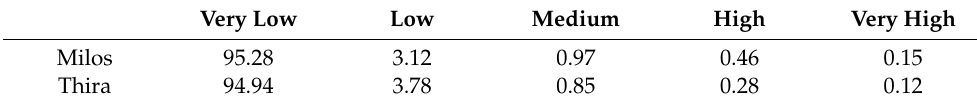
Table 8. Percentages of susceptibility classes to soil erosion in Milos and Thira islands. Very Low Low